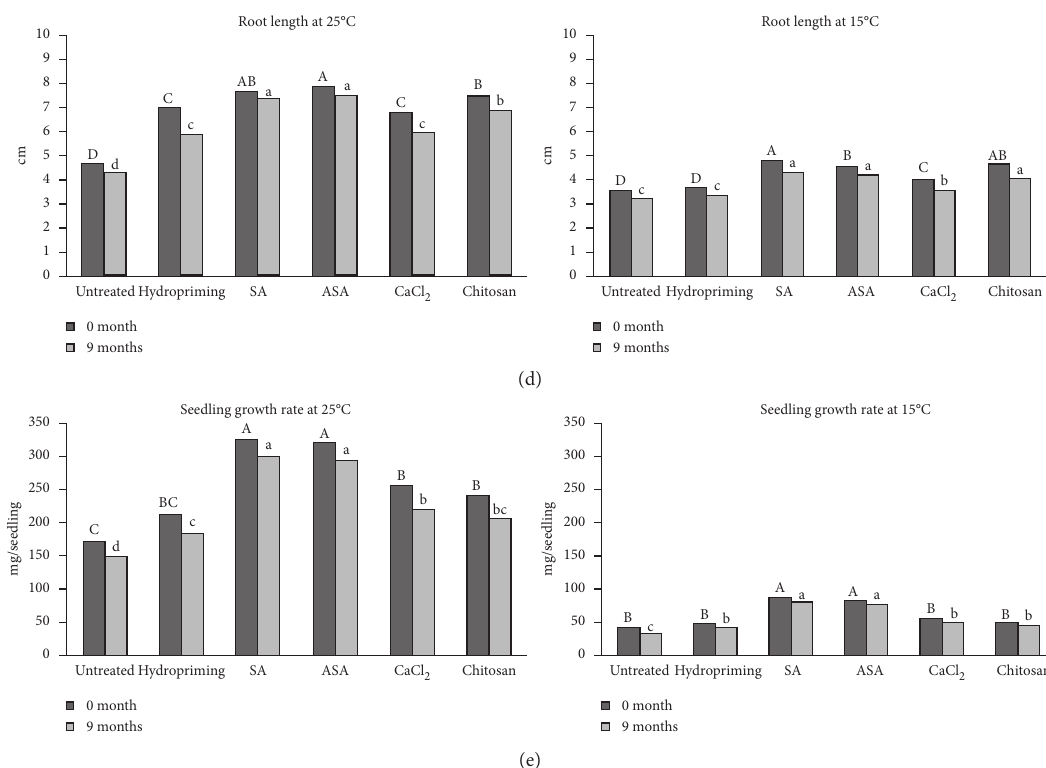
Figure 1: Effects of seed priming on germination, mean germination time, shoot height, root length, and seedling growth rate of Tainan 9 peanut seeds after nine months of storage when germinated at 25 ° C and 15 ° C. Means among bar charts followed by the same uppercase (lowercase) letters are not significantly different at P < 0 . 05 by LSD for 0-month (9-month)